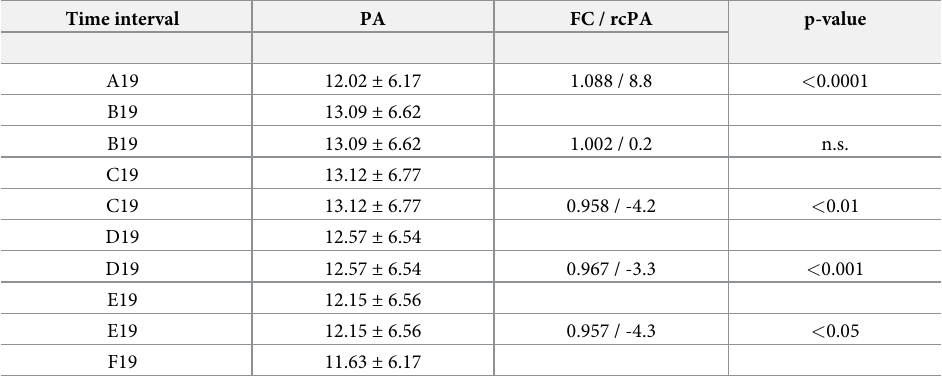
Table 2. Comparison of physical activity of adjacent time intervals in